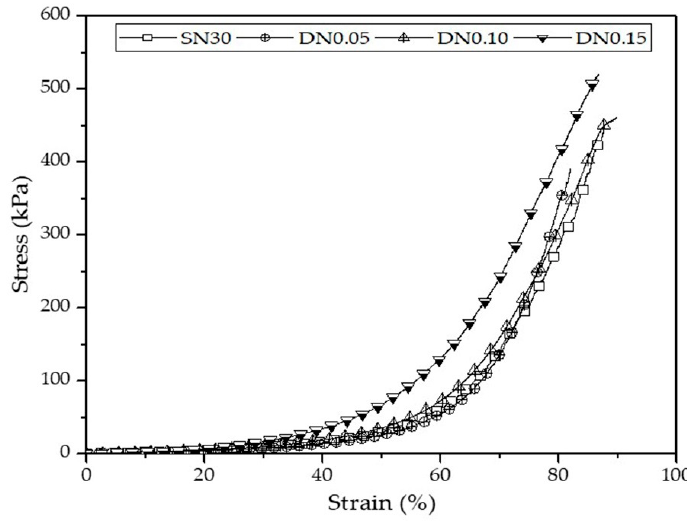
Figure 11. Stress-strain curves of SN30 and DN starch hydrogels prepared with various borax concentrations. Table 4. Compressive properties of SN starch hydrogel (30 mL of GA and 24 h of crosslinking time) and DN starch hydrogels ( n = 5 , * p < 0.05 compared with DN0.15 hydrogel).